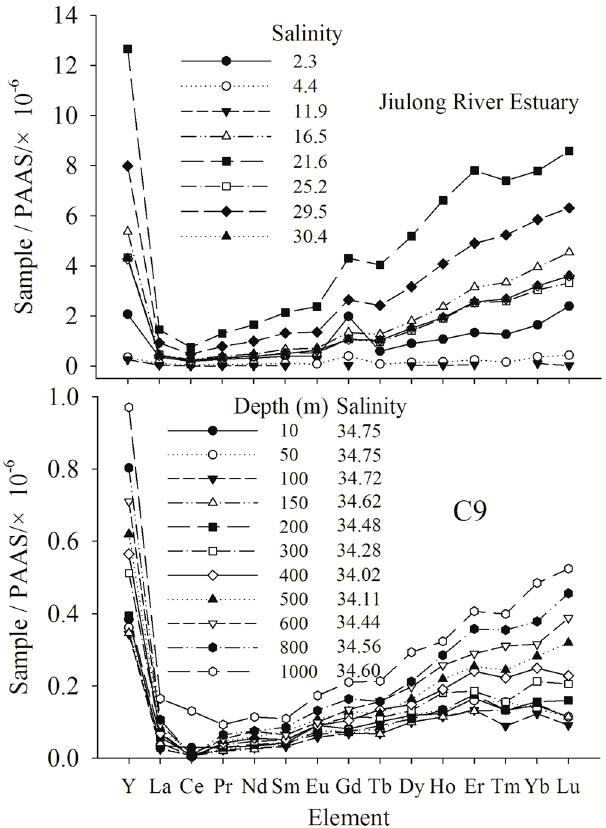
Figure 5. PAAS normalized YREEs patterns in surface water of Jiulong River Estuary and in station C9 (22°07 ′ 13 ″ N, 118°24 ′ 41 ″ E) of Taiwan Strait.